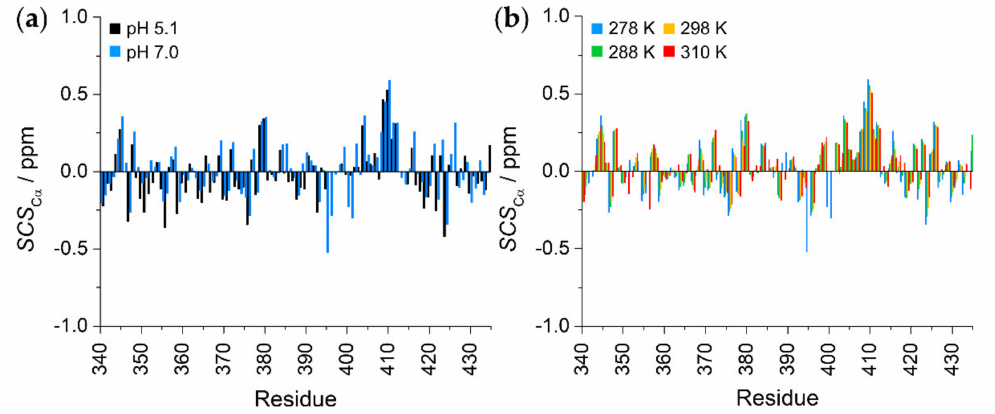
Figure 3. 13 C α secondary chemical shifts of the EZH2 loop: ( a ) pH dependence of SCS values at 278 K. ( b ) Temperature dependence of SCS values at pH = 7.2. Random coil chemical shifts were calculated with POTENCI